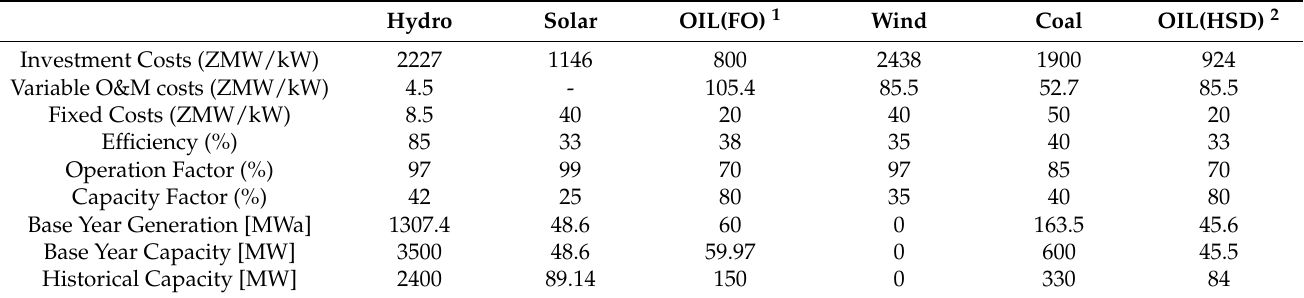
Table 4. Summary of technical and economic characteristics of conversion technologies [29].